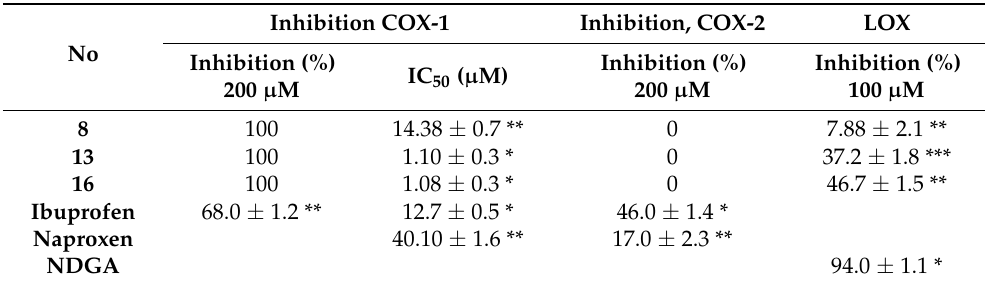
Table 3. Activity effect of compounds on cyclooxygenase (COX) -1 and -2, and LOX. Inhibition No